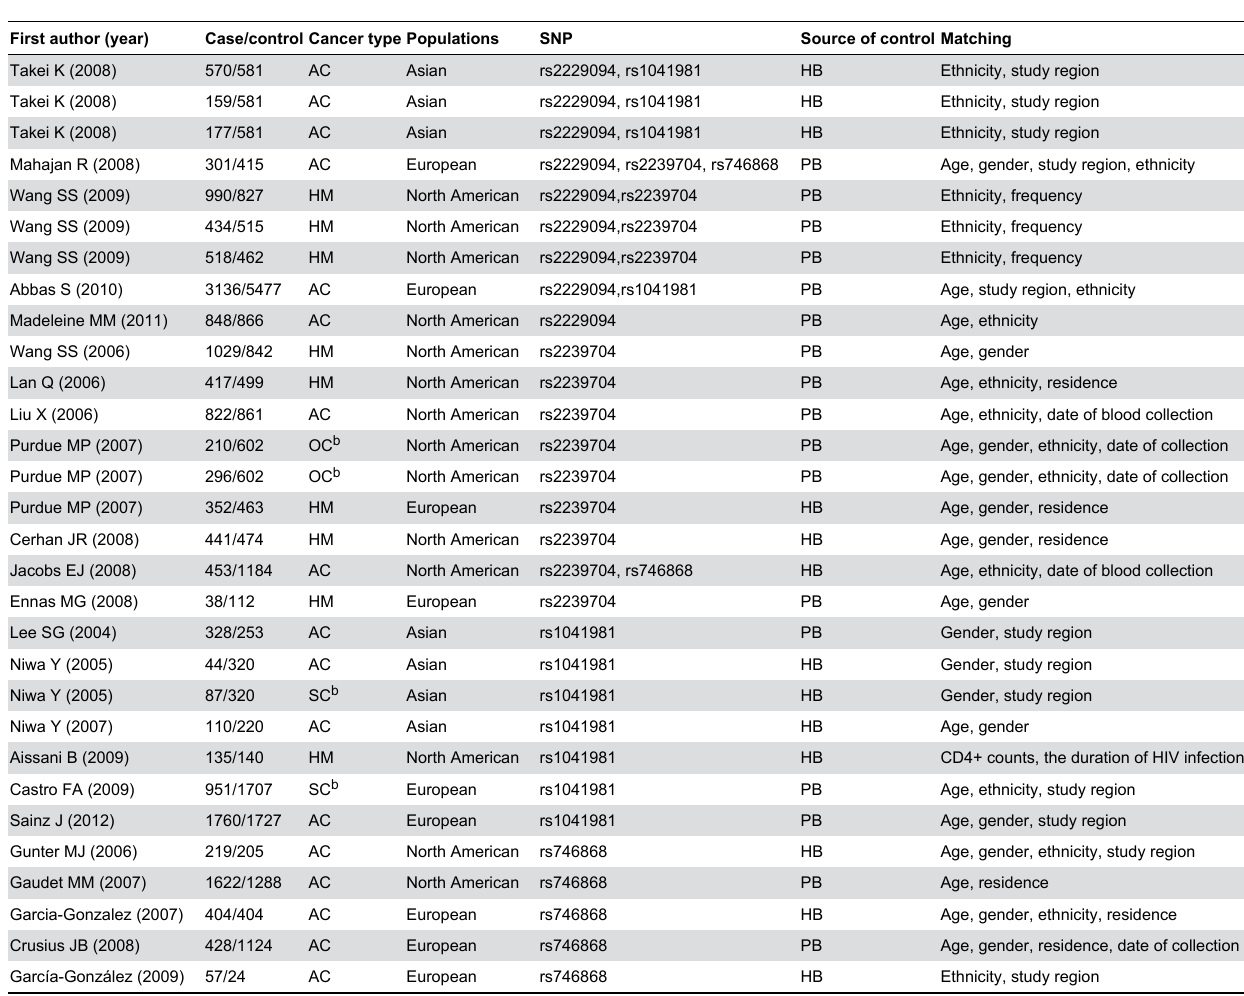
b: The two studies of squamous carcinoma are all cervical cancer; the two studies of other cancer are testicular germ cell tumors (TGCT) including seminoma and no